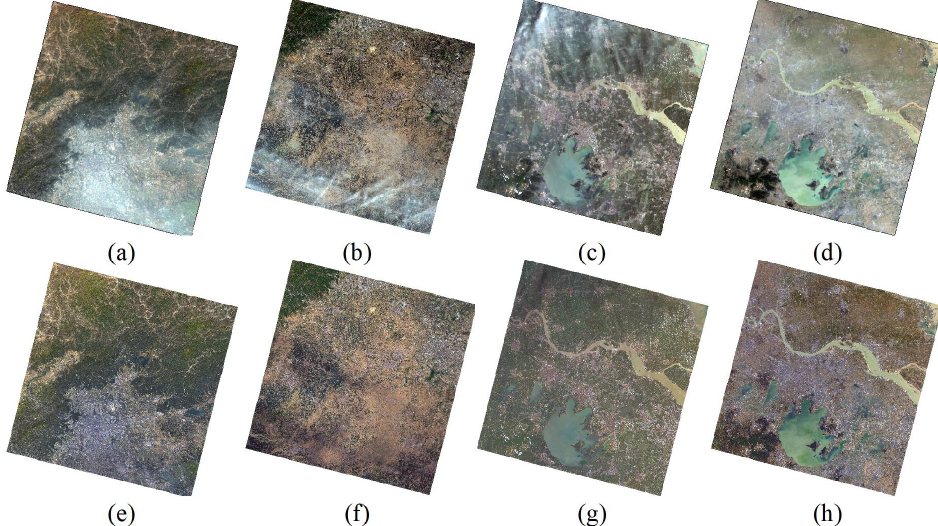
Figure 12. Dehazing results of full-size Landsat 8 OLI data using MODEL-T. ( a – d ) original hazy images with spatially varying haze or clouds; ( a ) path 123, row 032, acquisition date 3 October 2013; ( b ) path 123, row 033, acquisition date 7 May 2015; ( c ) path 119, row 038, ( d ) acquisition date 22 July 2017; path 119, row 038, acquisition date 29 December 2014); ( e – h ) dehazed images.